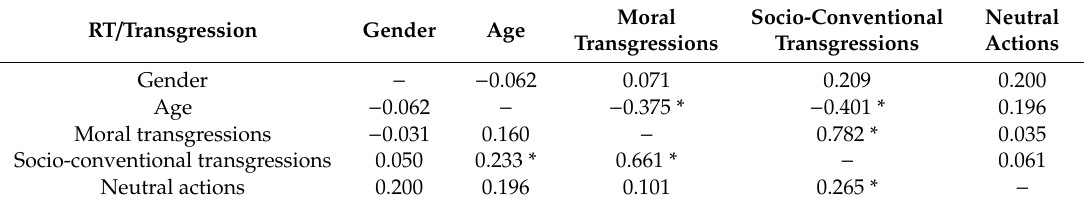
Table 2. Associations (Pearson r ) between reaction time and acceptability of transgressive / neutral actions with age and gender ( N =